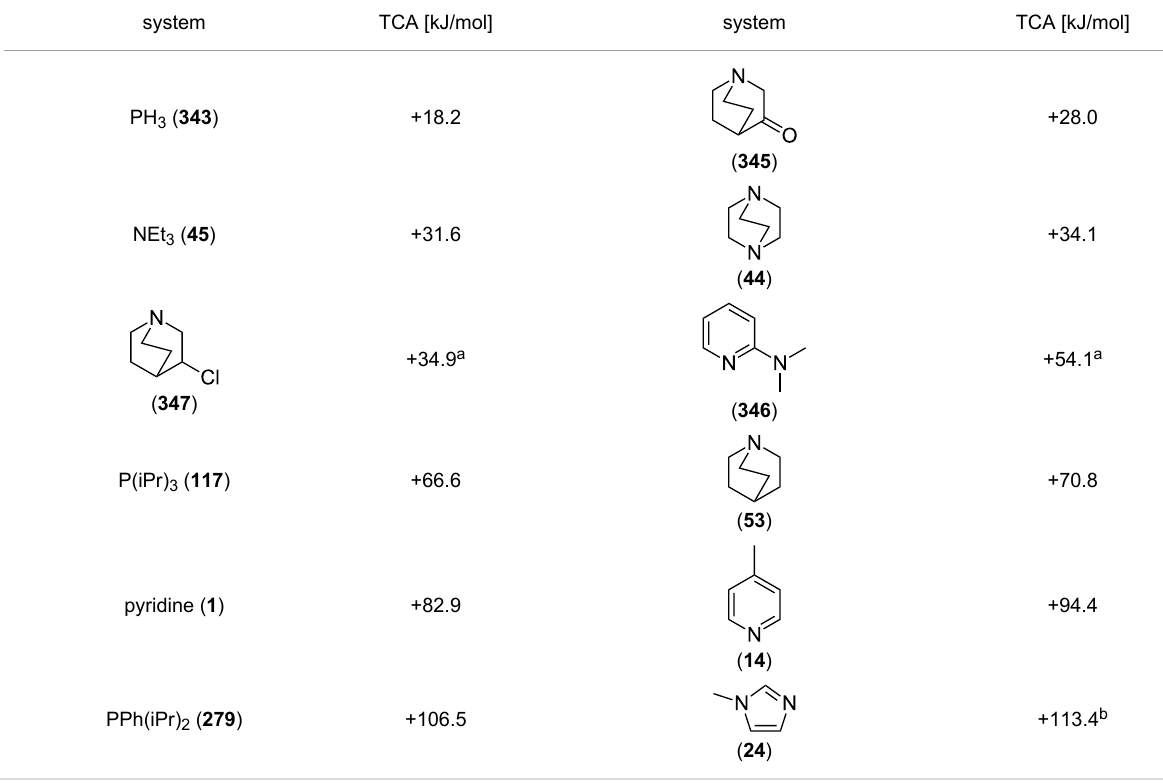
The TCA values of some Lewis bases commonly used in organocatalysis as well as various phosphanes and phosphites are shown in Table